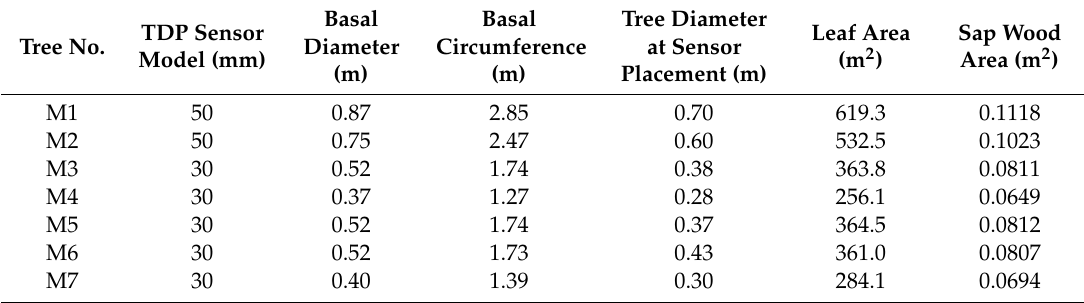
Table 2. Sensor information and characteristics of the mature juniper trees. Basal diameter, basal circumference, and tree diameter at sensor placement were measured. Leaf area and sap woody area were